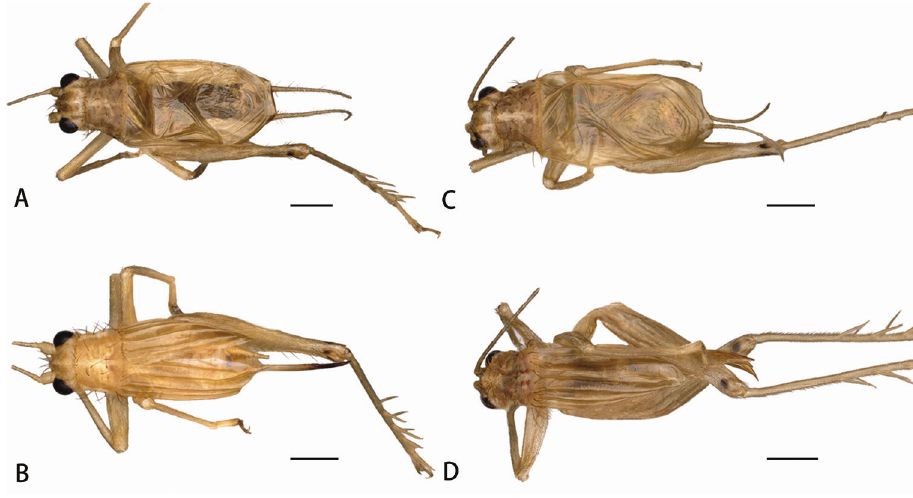
Figure 3. Habitus photographs. A, B A. nonggangensis sp. nov. C, D A. manereserratus sp. nov. A, C Male B, D Female. Scale bar: 1